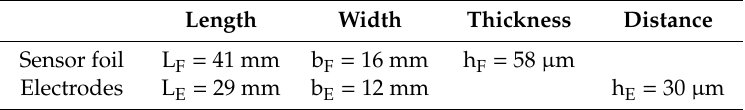
Table 1. Geometrical dimensions of PVDF sensor foils and electrodes.